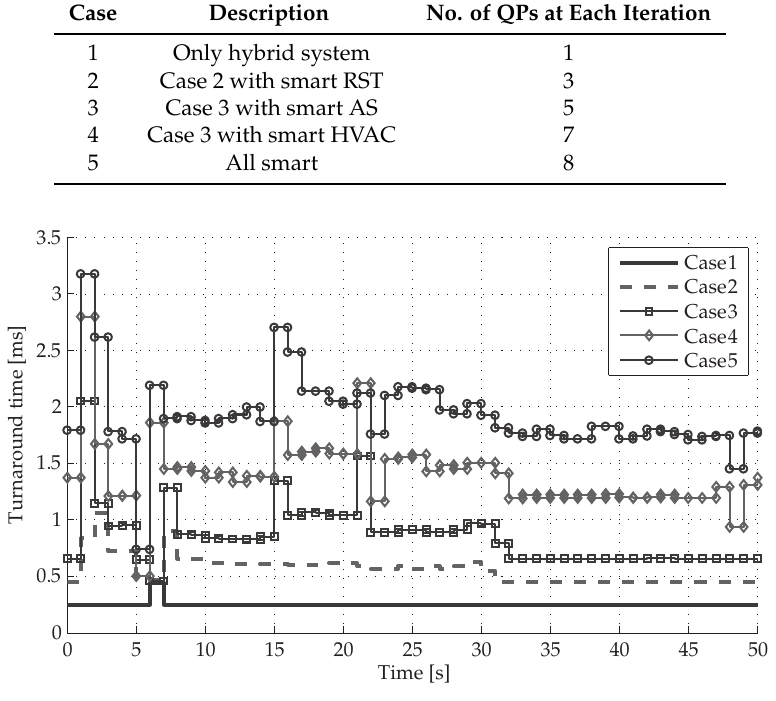
Figure 11. Turnaround